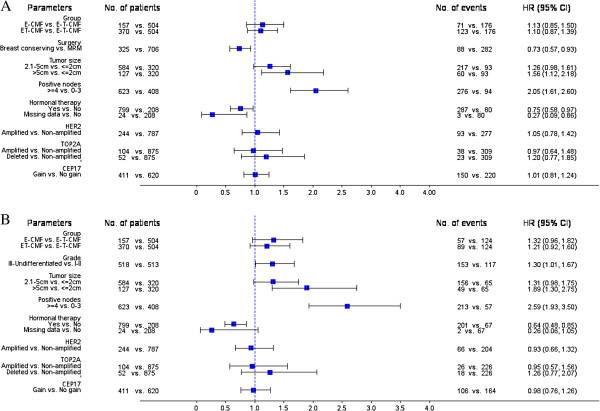
Multivariate analyses presented by forest plots in terms of DFS (A) and OS (B).